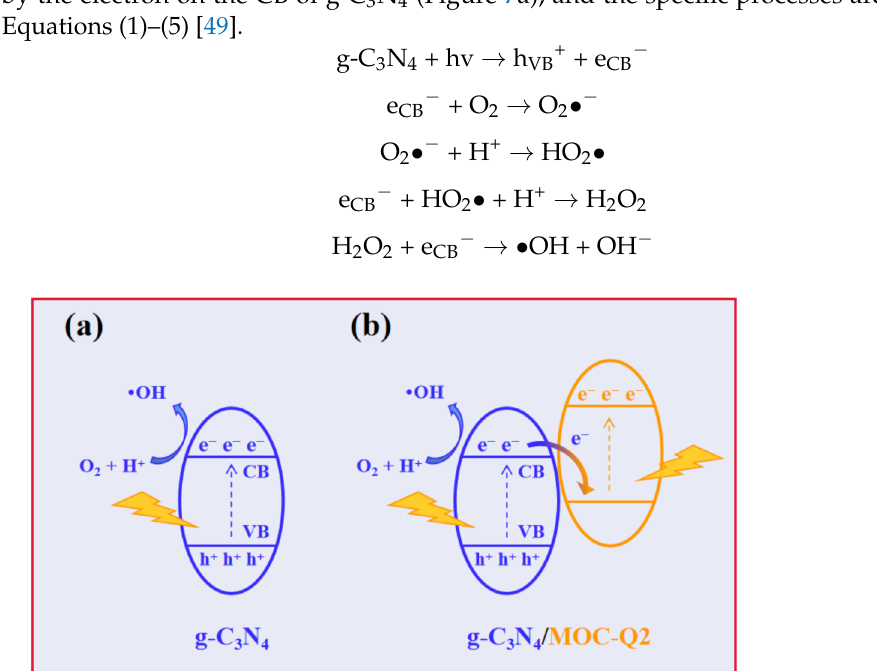
Figure 7. Mechanism for electron transfer and • OH generation of ( a ) g-C 3 N 4 and ( b ) g-C 3 N 4